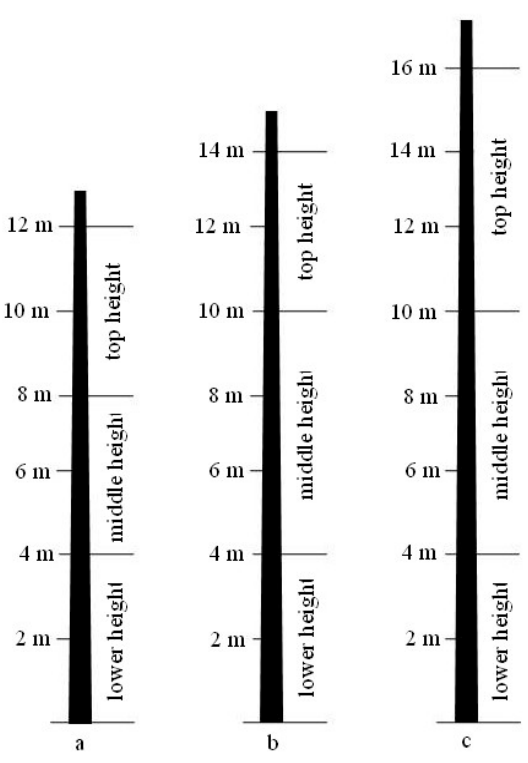
Figure 2. Height zones on the stem, depending on the number of 2 m long wood sections ( a —6 sections, b —7 sections, c —8 sections).